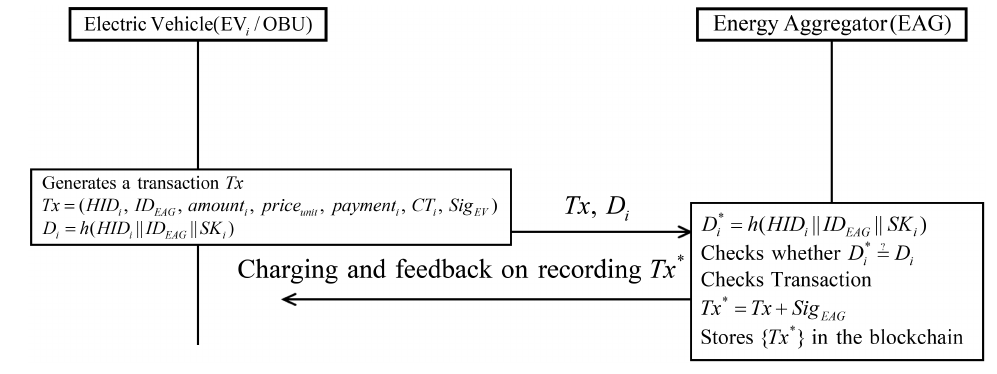
Figure 8. Charging phase of proposed